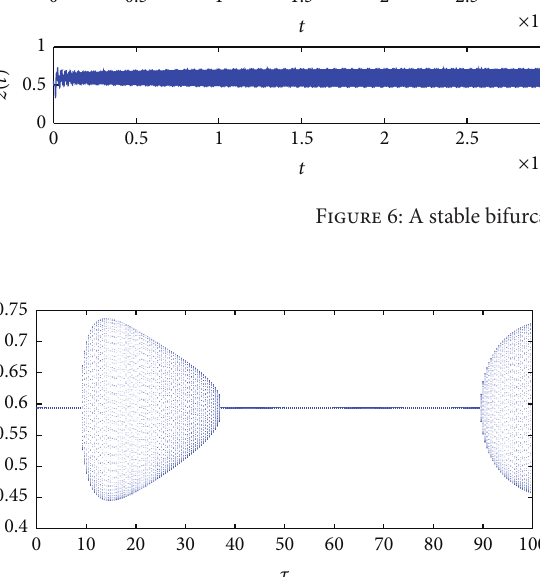
Figure7:Abifurcationdiagraminwhich 𝜏